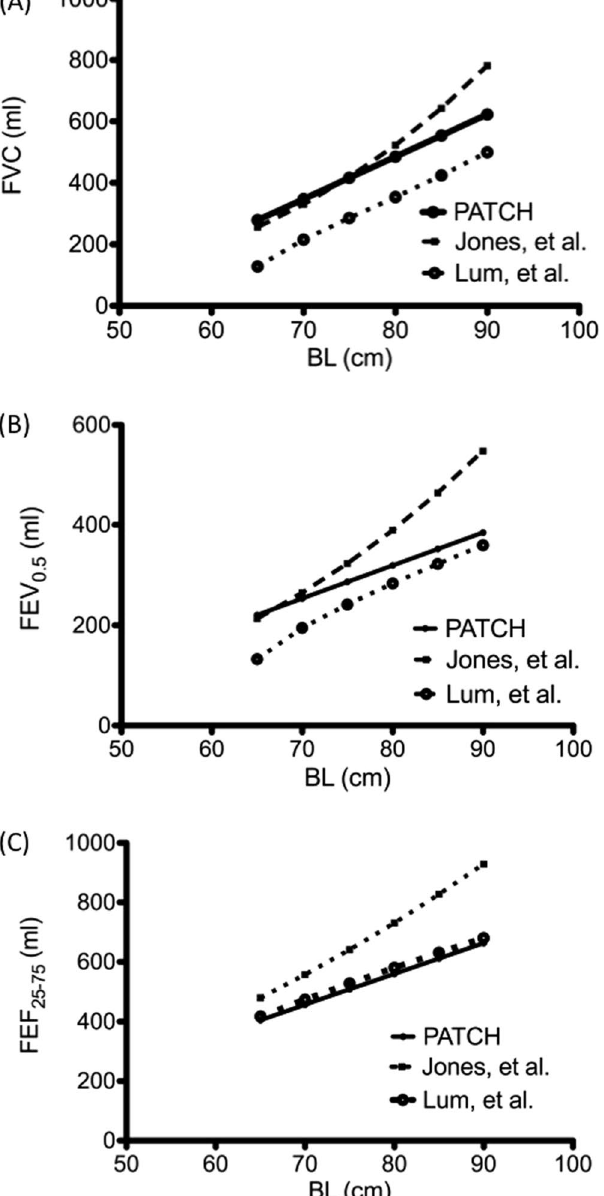
Figure 3. Comparison of various reference curves. Present regressions of forced vital capacity (FVC) ( A ), forced expiratory volume at 0.5 (FEV 0.5 ) ( B ), and forced midexpiratory flow (FEV 25–75 ) ( C ) in the study compared with previously published reference